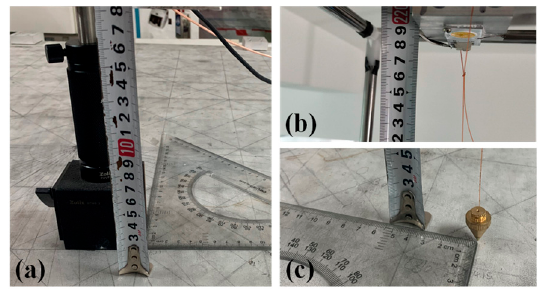
Figure 4. Measurements of the ground truth locations of ( a ) PD, ( b ) and ( c ) LED. Table 2. Experimental parameters.